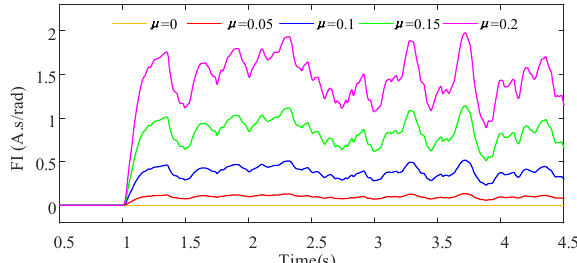
Figure 14. Fault detection results at random wind speed with different μ .